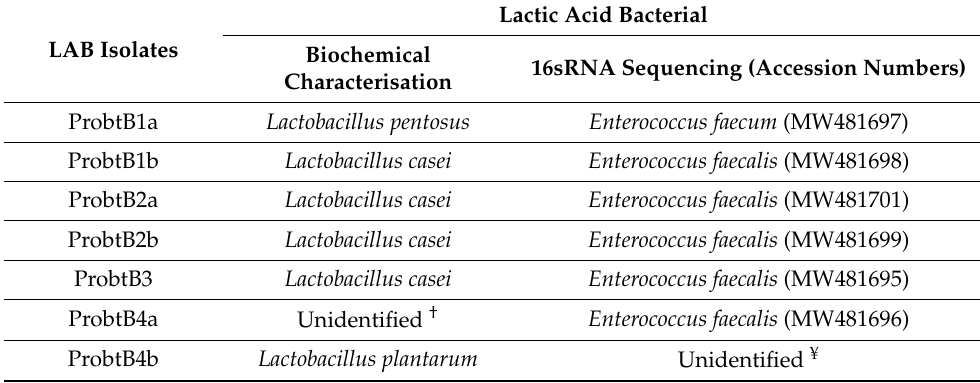
Figure 1. The characterisation of the LAB isolates with 16S rRNA. Table 2. Organisms identified using biochemical characterization and genomic